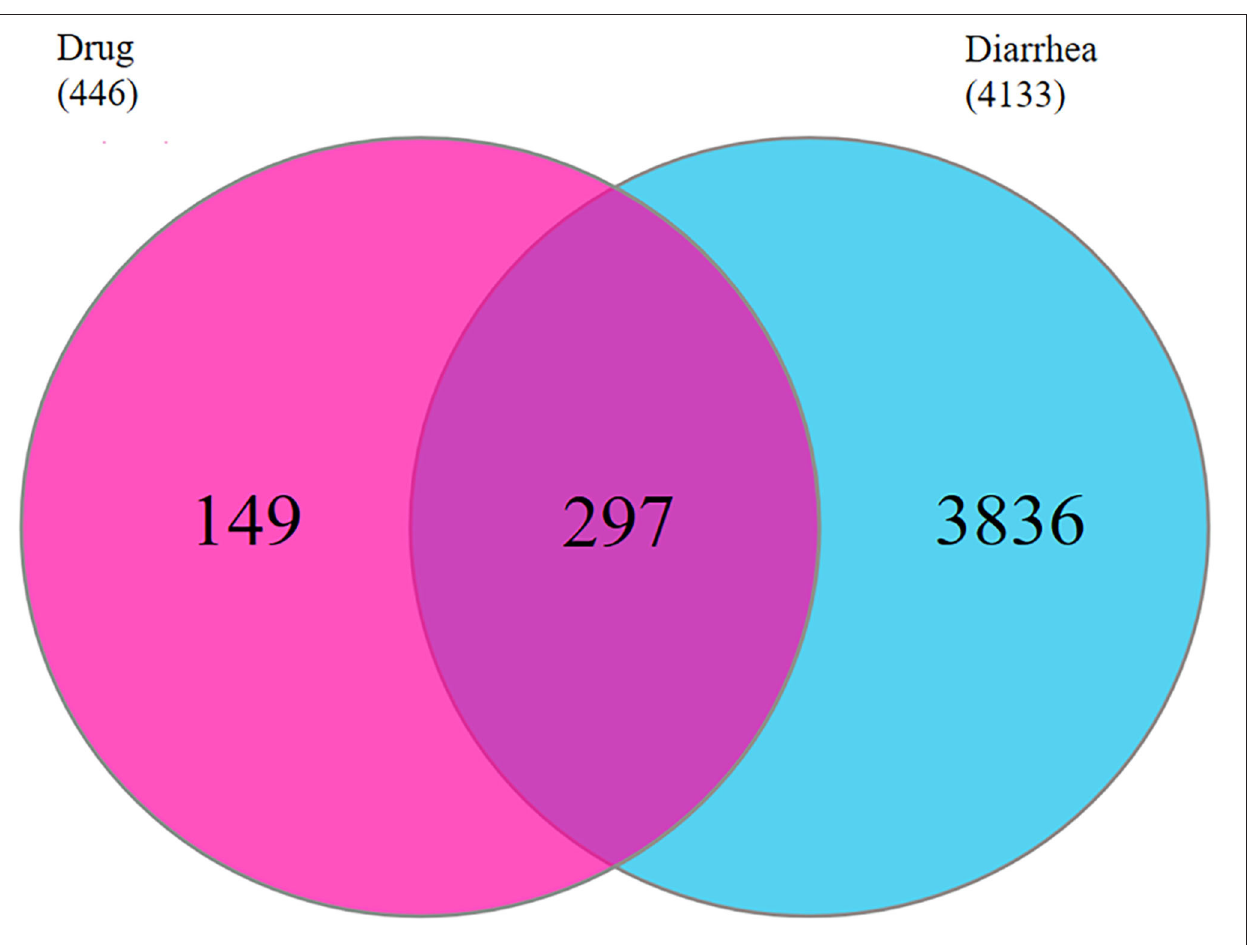
embedding were performed, and 5-mm sections were cut and stained with hematoxylin and eosin (H&E). Morphologic changes in the intestinal villi, crypt depth, and goblet cells were observed under a microscope (28). ImageJ was used (version 1.52) to measure villus height, crypt depth, and villus height/crypt depth. Goblet cells were